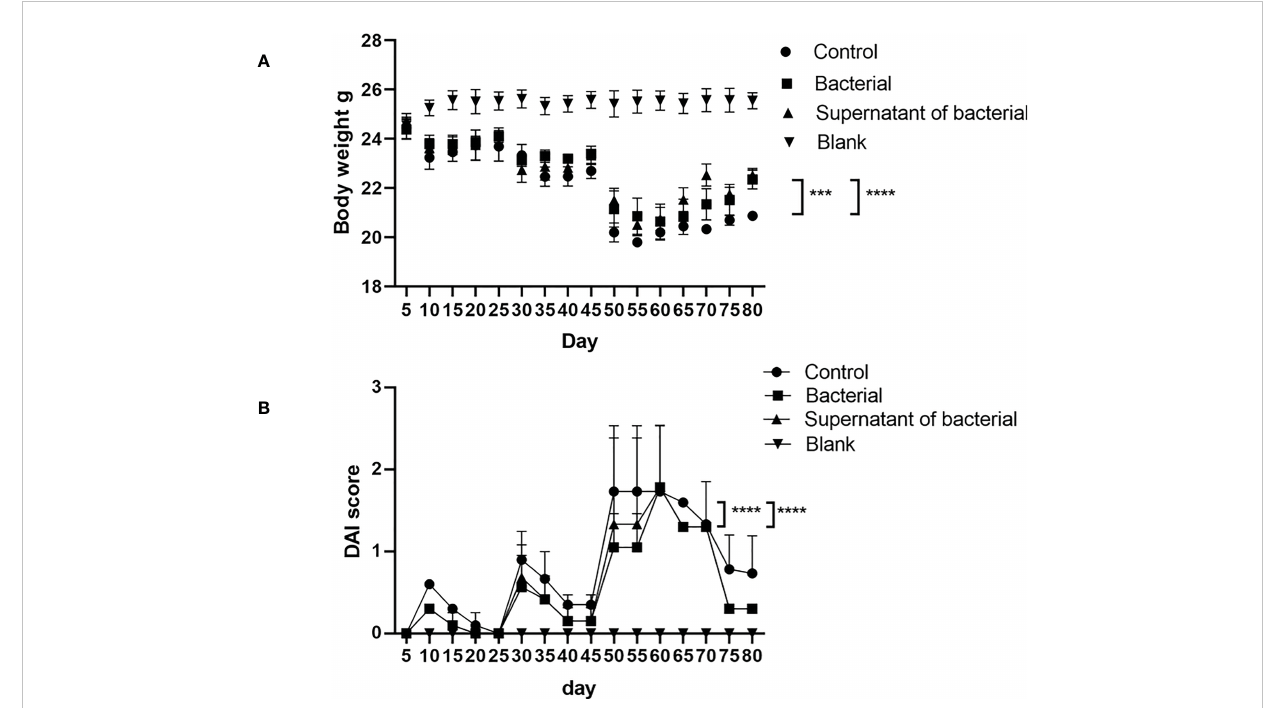
FIGURE 3 Analysis of body weight and DAI in mice. (A) Comparison of body weight among the different groups. (B) Comparison of DAI among different groups. The data are presented as mean ± SEM and compared using two-way ANOVA. ***P<0.0005, and